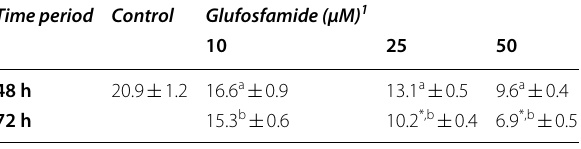
Table 8 Effects of glufosfamide on ATP level in HepG2 cells